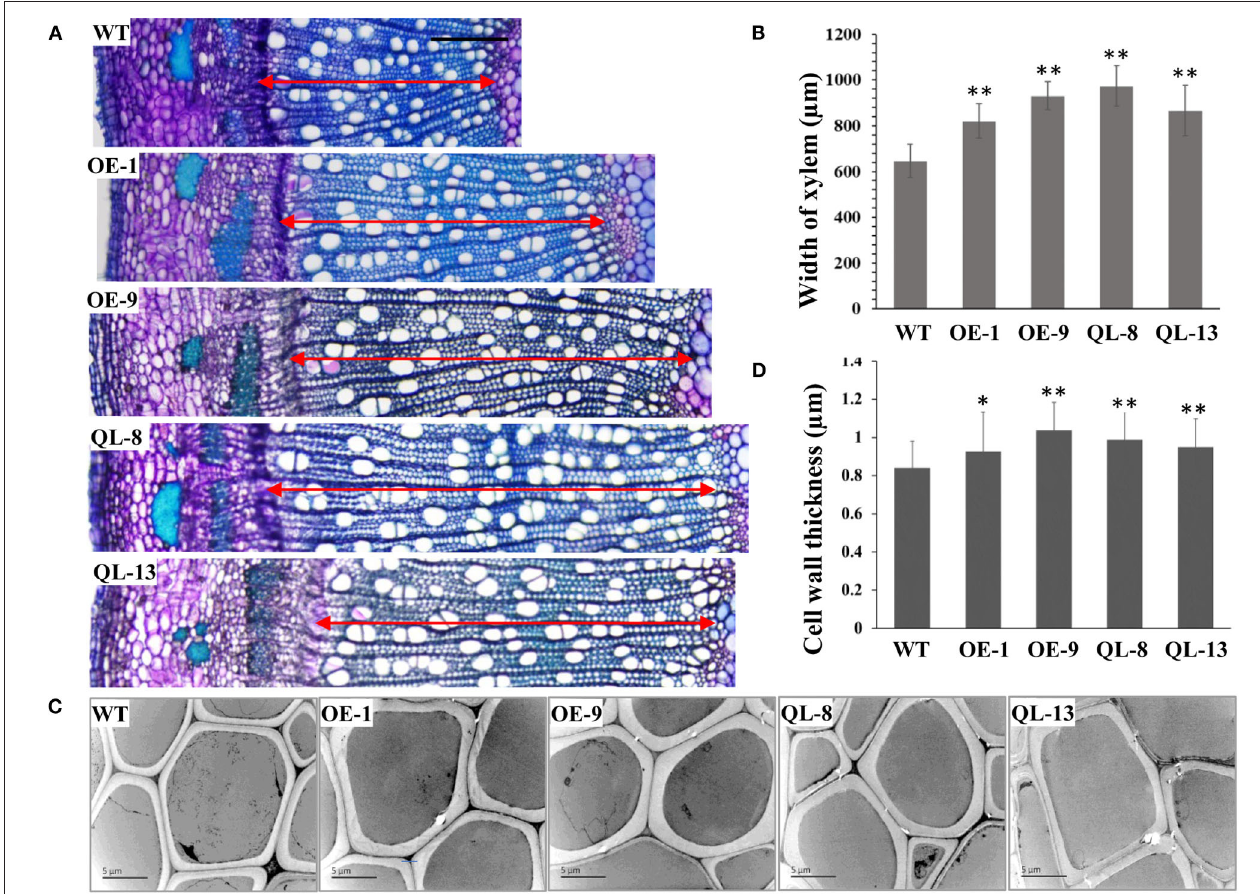
FIGURE 3 | Xylem development was increased by PagRabE1b overexpression. (A) Transverse sections of the basal stems of 3-month-old WT, OE-1, OE-9, QL-8, and QL-13 plants. Bar = 200 µ m; (B) Transmission electron microscopy (TEM) examination of the cell wall thickness of xylem fiber cells in 3-month-old WT, OE-1, OE-9, QL-8, and QL-13. Bar = 5 µ m. (C) Statistical analysis of xylem width in the stems of WT, OE-1, OE-9, QL-8, and L-13 lines. (D) Statistical analysis of the cell wall thickness of WT, OE-1, OE-9, QL-8, and QL-13 lines. Student’s t -test; * P < 0.05; ** P <